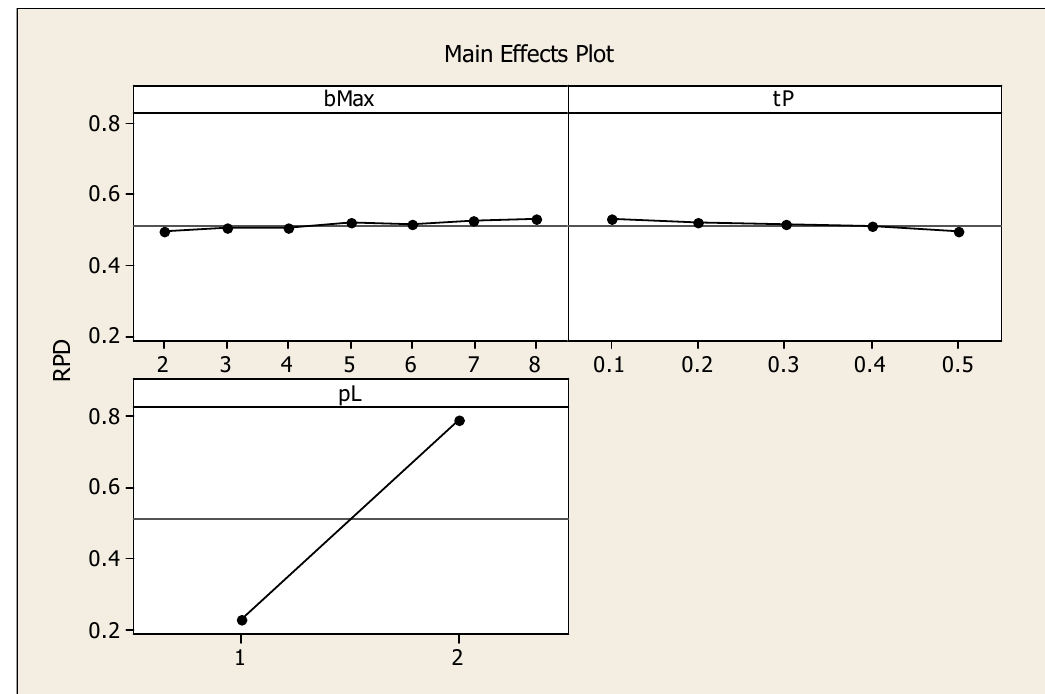
Figure 3. Main effects plot for parameters of VBIH. Figure 3. Main e ff ects plot for parameters of VBIH.